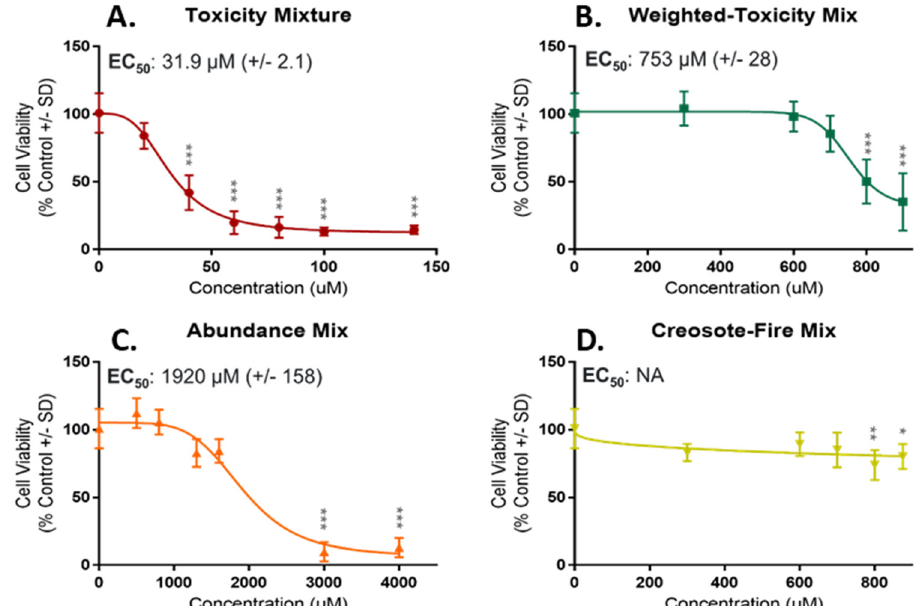
Figure 5. Concentration ‐ Response Curves for Cell Viability in NHBE . Curves are in order from high to low potency based on predicted EC 50 values. ( A ) Toxicity Mix was the most potent mixture with an EC 50 of 31.9 μ M. ( B ) Weighted ‐ Toxicity Mix was the second most potent mixture with an EC 50 of 753 μ M. ( C ) Abundance Mix was the least potent mixture with EC 50 of 1920 μ M. ( D ) Creosote ‐ Fire Mix had significant bioactivity for two highest doses, however, no EC 50 was calculated. Concentrations significantly different from control are denoted with an asterisk (*). p < 0.05 *; p < 0.01 **; p < 0.001 ***.